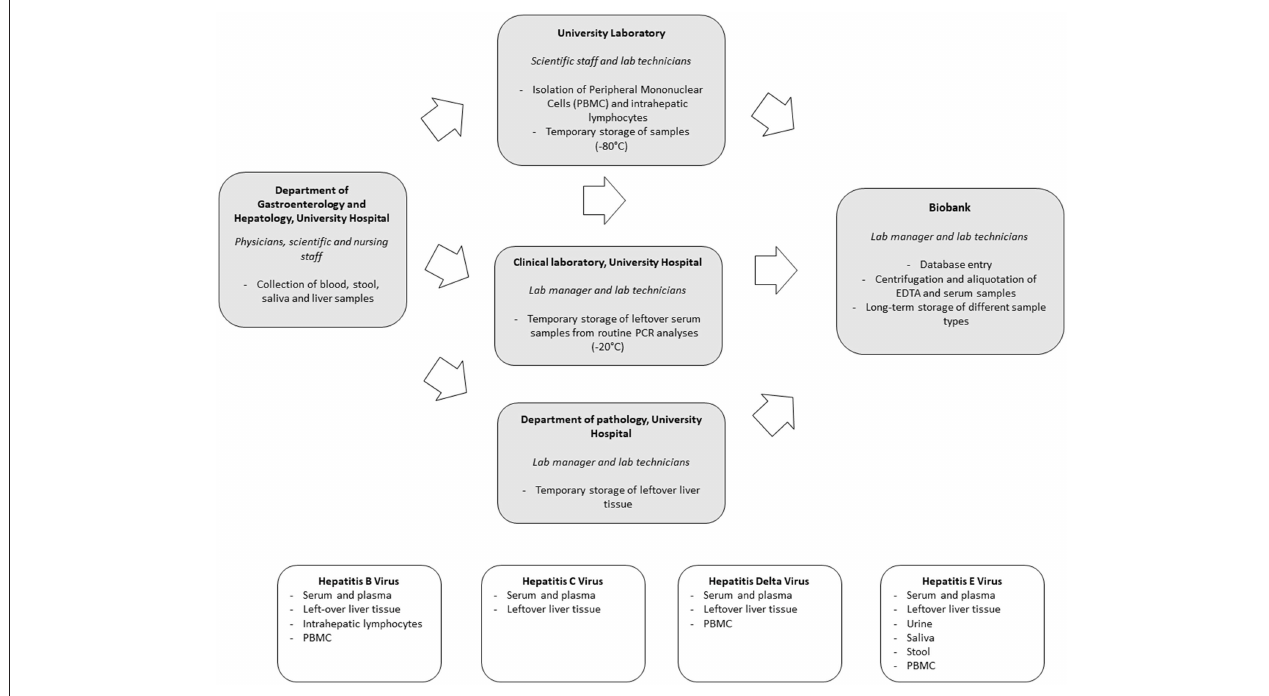
FIGURE 1 | Sample flow and types of samples collected during hospital-based biobanking.